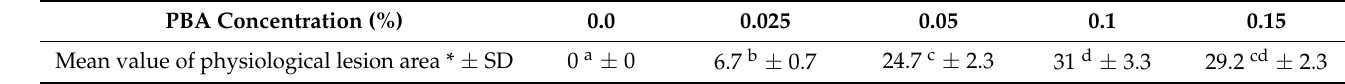
Table 3. Effect of PBA on tomato plants, 14 days after